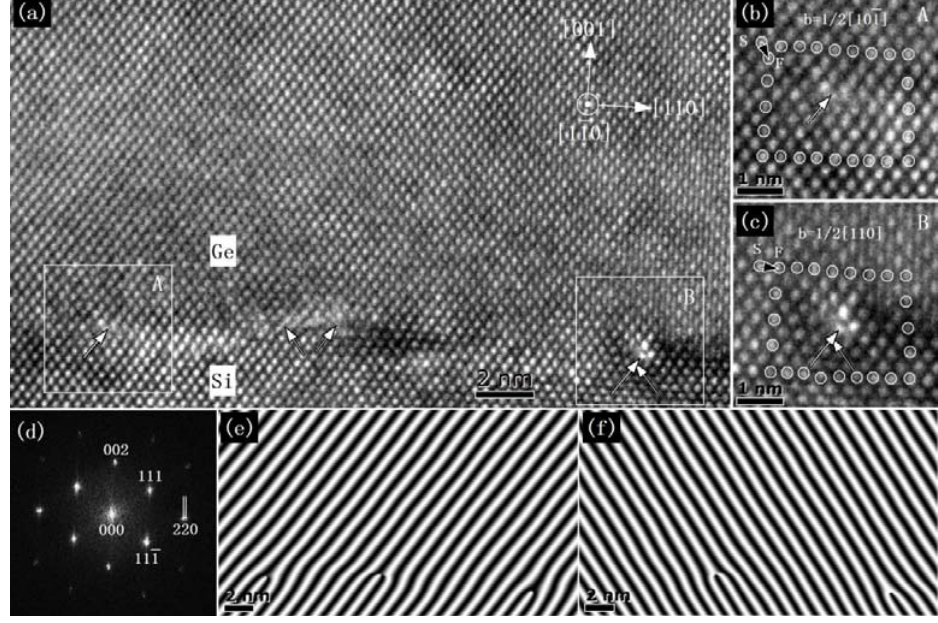
Figure 1. Electron micrograph of a Ge/Si heterostructure: ( a ) high-resolution transmission electron microscopy (HRTEM) image of the Ge/Si heterostructure; ( b ) Burgers circuit around a 60° dislocation; ( c ) Burgers circuit around a 90° full-edge dislocation; ( d ) fast Fourier transform (FFT) pattern of the HRTEM image of the Ge/Si heterostructure; ( e ) 3× numerical moiré pattern of the ( e ) ( 111 ) crystal plane; ( f ) 3× numerical moiré image of the (111) crystal plane.